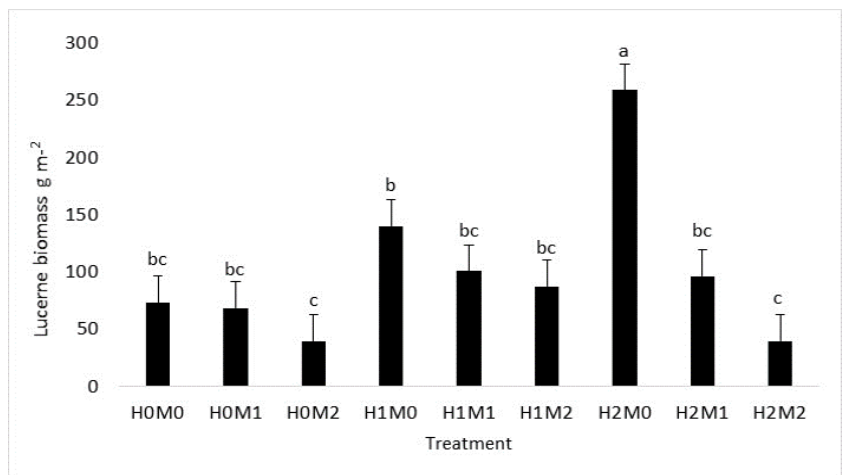
Figure 4. Mean (± pooled SE) lucerne biomass (g∙m −2 ) present as a result of the interaction between herbicide and mowing after 24 months (2017) in a barley grass-infested mixed pasture stand. Bars with the same letter are not significantly different ( p < 0.05) after the Scheffe correction for type I error. H0, H1, H2: no herbicide, herbicide 1 (propaquizafop), herbicide 2 (paraquat), respectively. M0, M1, M2: No mow, one mow, repeat mow, respectively.